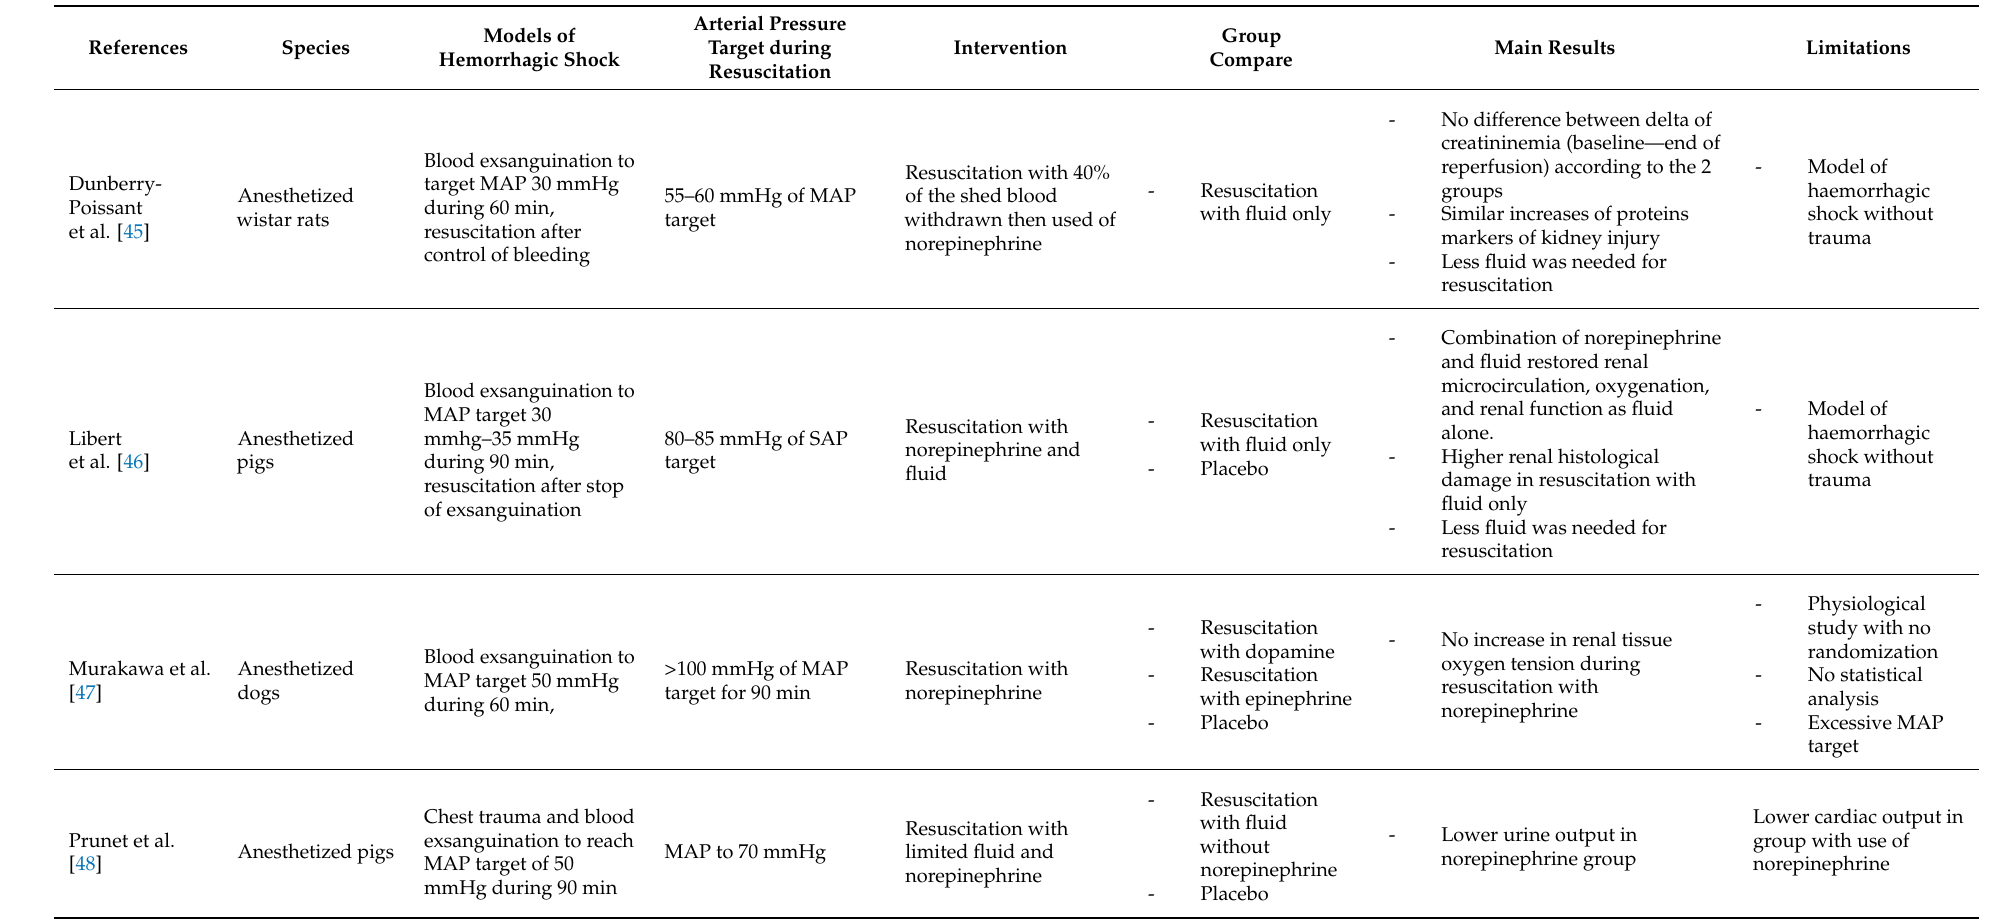
Table 1. Norepinephrine and kidney during hemorrhagic shock. MAP: mean arterial pressure, SAP: systolic arterial